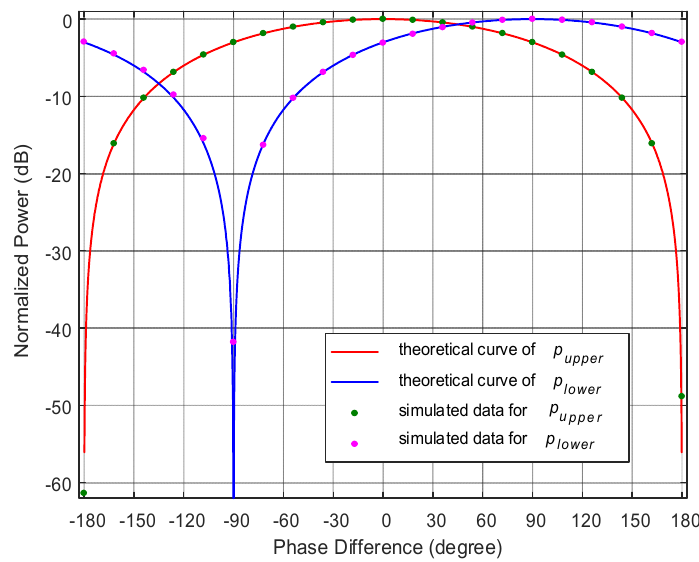
Figure 5. The simulated results of actual data and theoretical curve for normalized power of the output signals versus phase difference of the two echo signals.